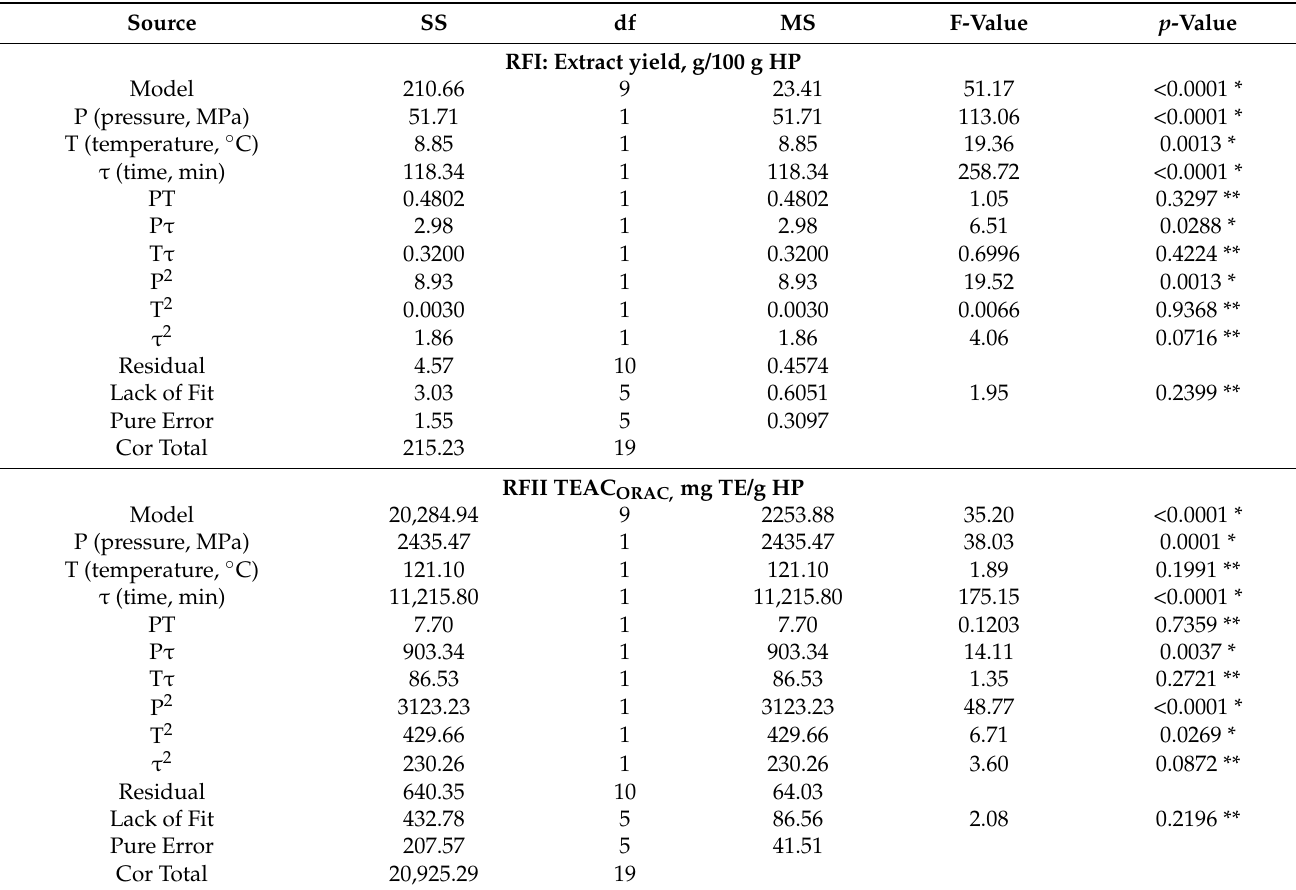
Table 3. Analysis of variance of the regression parameters for the response surface quadratic models of Ella hop SFE-CO 2 extract yield (RFI) and TEAC ORAC